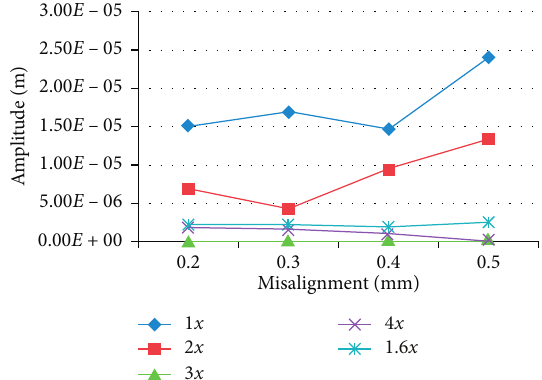
Figure 24: Spectrum of misalignment and unbalance in bearing 4, Ω Figure 25. The test results confirm the simulation results